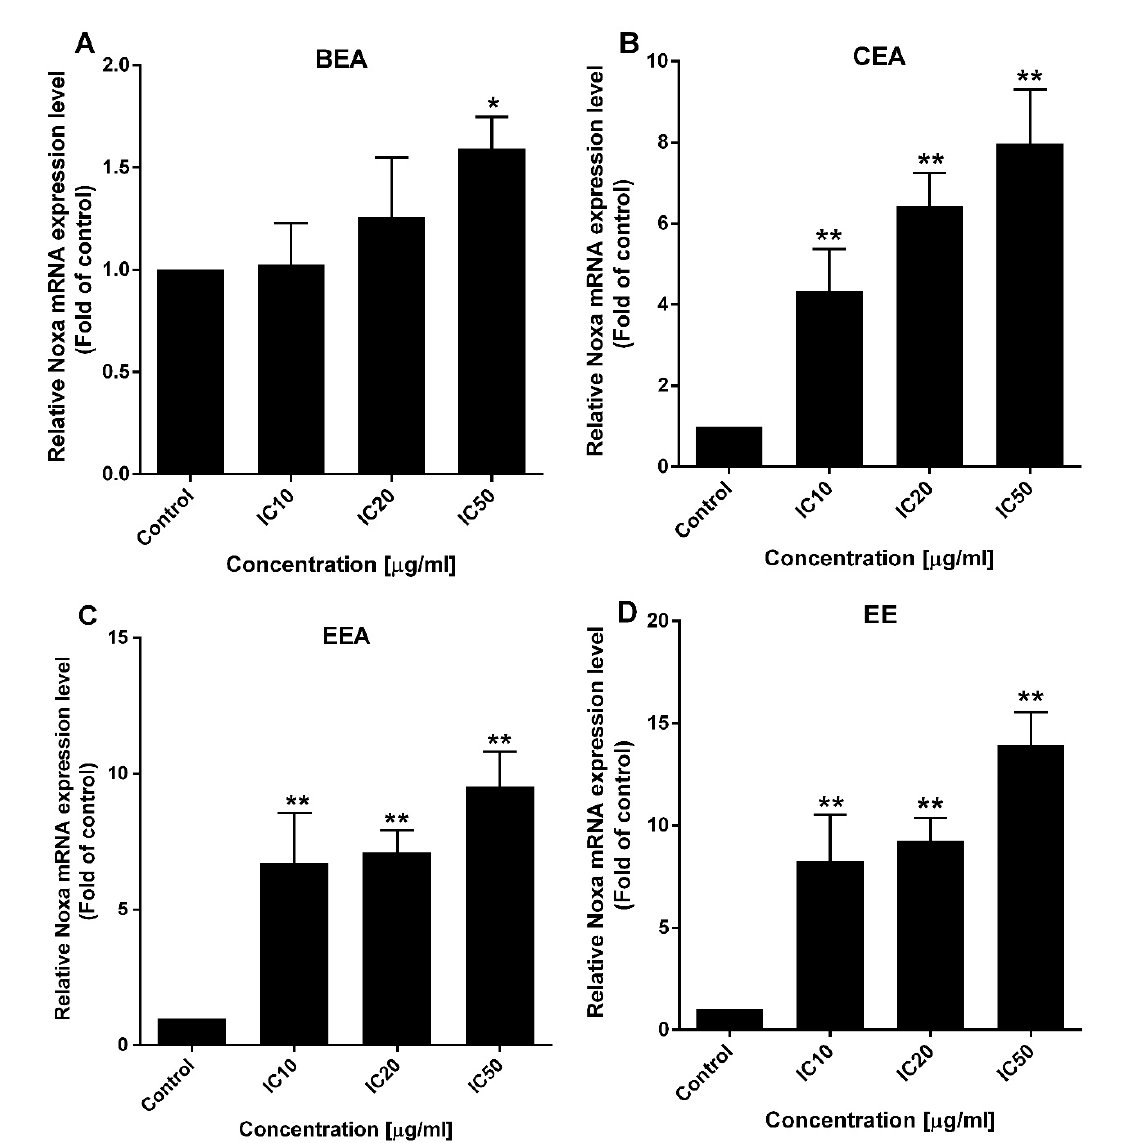
Figure 9. The effect of the effective extracts on Noxa mRNA expression level. Quantitative RT-PCR of the mRNA expression of Noxa mRNA was measured by a 7500 Fast Real-time PCR system. A549 cells were treated with ( A ) BEA, ( B ) CEA, ( C ) EEA, and ( D ) EE at the indicated concentrations. The relative gene expression level was analyzed by 2 − ∆∆ Ct , using GAPDH as a housekeeping gene. * p < 0.05, ** p < 0.01, treatment group vs. control un-treatment groups.